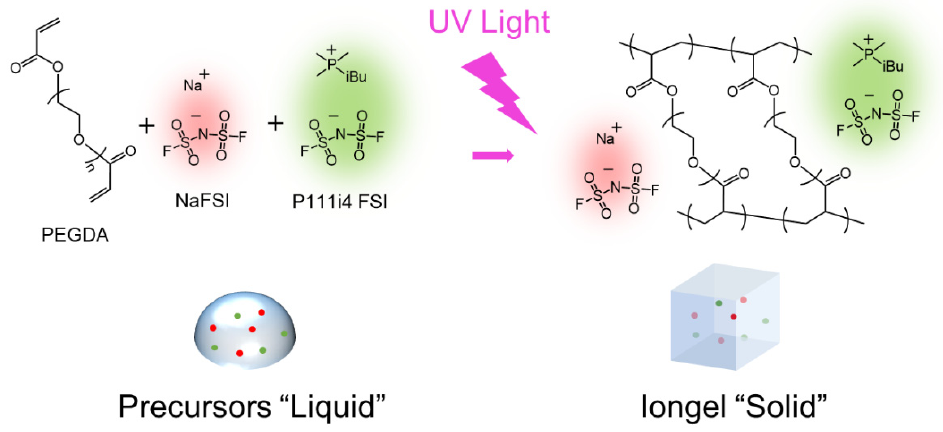
Figure 1. Synthetic representation of photopolymerization for the obtention of iongels.